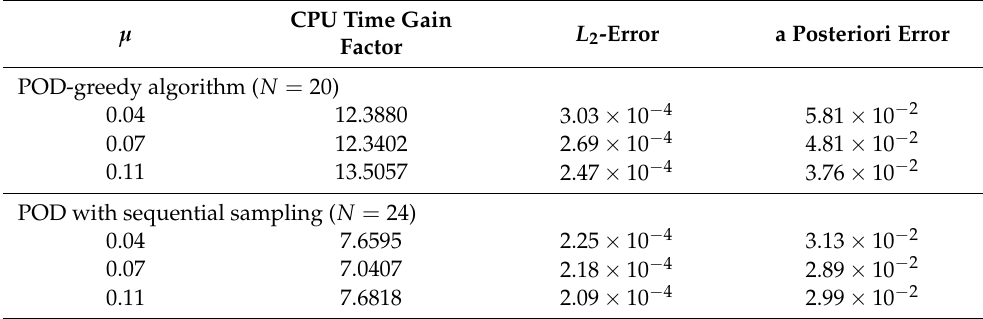
Table 3. CPU time gain factor and approximation error between the truth and the reduced basis solution at t = T end for a reduced basis of dimension N (Experiment